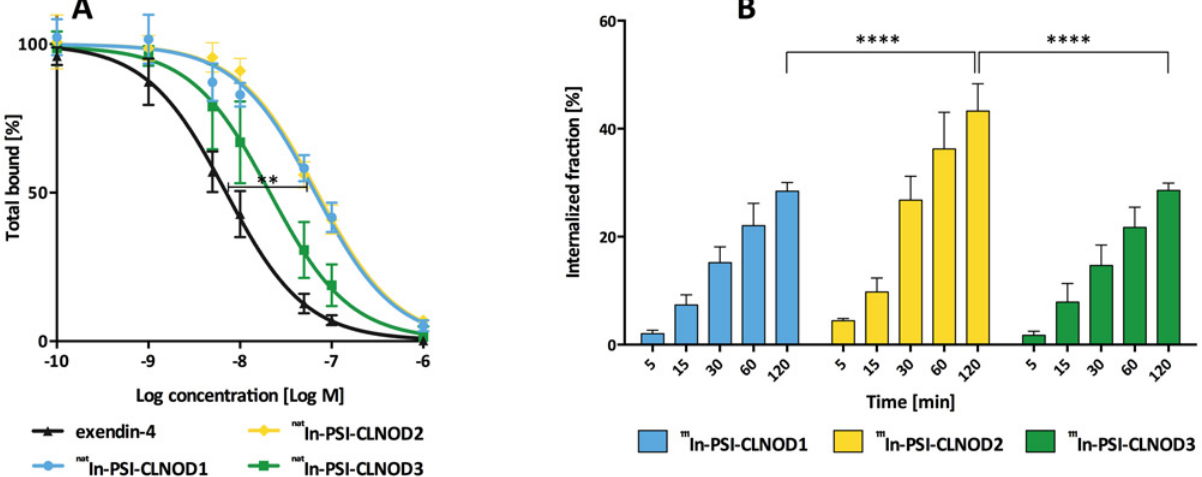
Fig 3. In vitro assessment of the peptides containing cleavable linkers in CHL cells expressing GLP-1R. (A) IC 50 values of nat In labelled peptides. 0.1 – 0.6 pmol 111 In-Ex4NOD40 was used as tracer. (B) Internalisation kinetics of the 111 In-labelled probes. 0.2 – 1 pmol of the respective 111 In-labelled peptide was used as tracer. Non-specific binding was determined by incubation with 1 μ M of nat In labelled peptide.